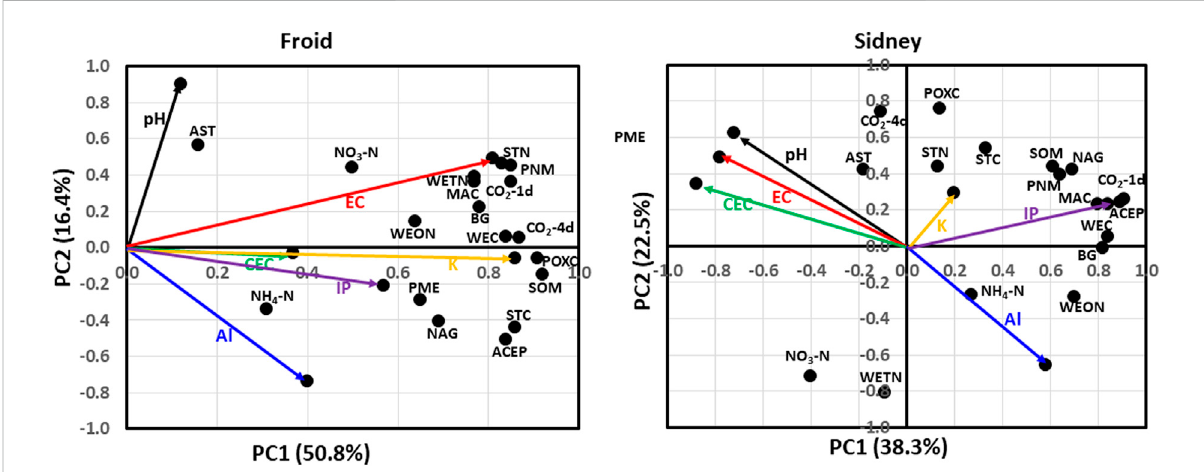
FIGURE 3 Principal component analysis for associations among soil pH, electrical conductivity (EC), cation exchange capacity (CEC), inorganic P (IP), K, and Al concentrations and soil biological and biochemical properties at Froid and Sidney, Montana, United States. At Froid, soil properties explained 50.8% of the total variation in the fi rst principal component (PC1) and 16.4% in the second principal component (PC2). At Sidney, soil properties explained 38.3% of the total variation in PC1 and 22.5% in PC2. ACEP denotes autoclaved citrate-extractable protein; AST, arylsulfatase; BG, β - glucosidase; CO 2 -1d, CO 2 fl ush at 1 d incubation; CO 2 -4d, CO 2 fl ush at 4 d incubation; MAC, microbially active C; NAG, N-acetyl β - glucosaminidase; PLFA, phospholipid-derived fatty acid; PME, phosphomonoesterase; PNM, potentially N mineralization; POXC, KMnO 4 - extractable C; SOM, soil organic matter; STC, soil total C; STN, soil total N; WEC, water-extractable C; WEON, water-extractable organic N; and WETN, water-extractable total